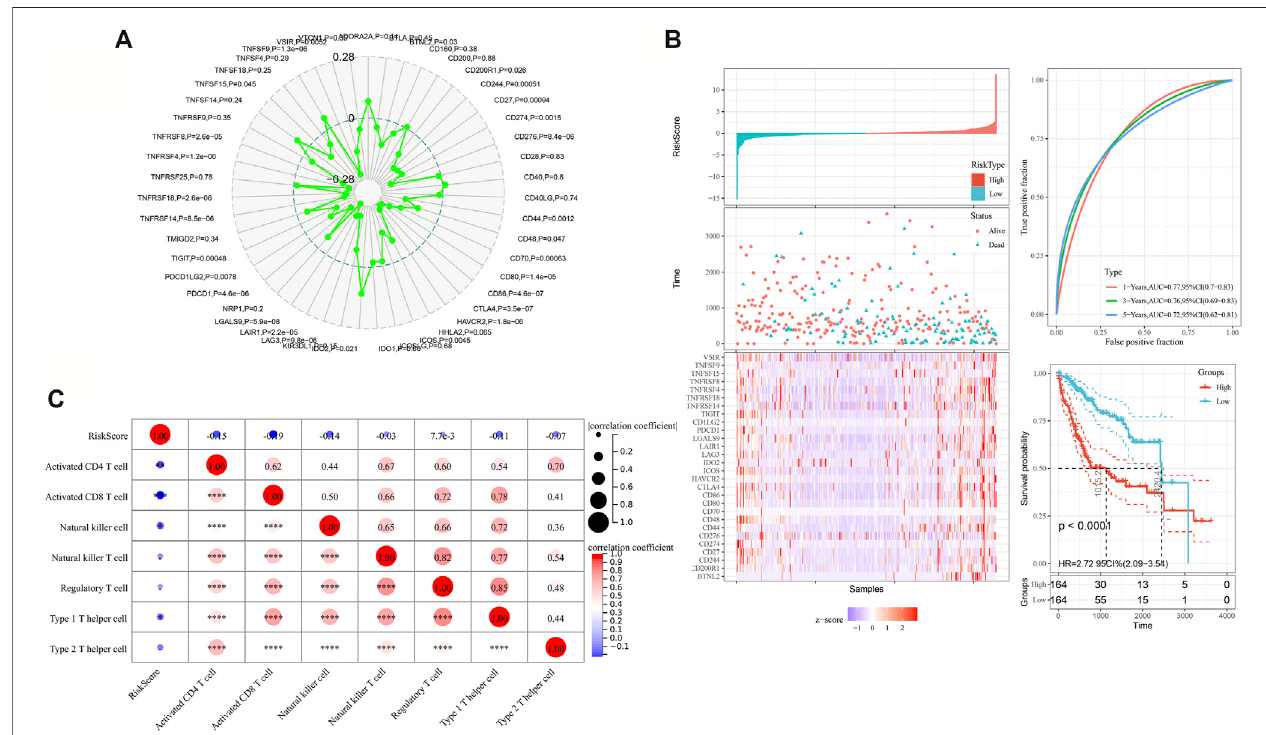
FIGURE 6 | MARC2 was negatively correlated with the immune checkpoint expression. (A) The association between MARC2 and immune checkpoints. The immunecheckpoints geneswereobtained fromSangerbox. (B) The riskscoreswere created by adding upthe product ofcoef fi cient ofeach gene and geneexpression in the left panel. The ROC and Kaplan-Meier curves were used to determine the prognostic value of risk score. (C) The correlation between risk score and immune cell types. The Pearson correlation coef fi cient was used to determine the correlation. *p < 0.05; **p < 0.01; ***p < 0.001; ***p < 0.0001.